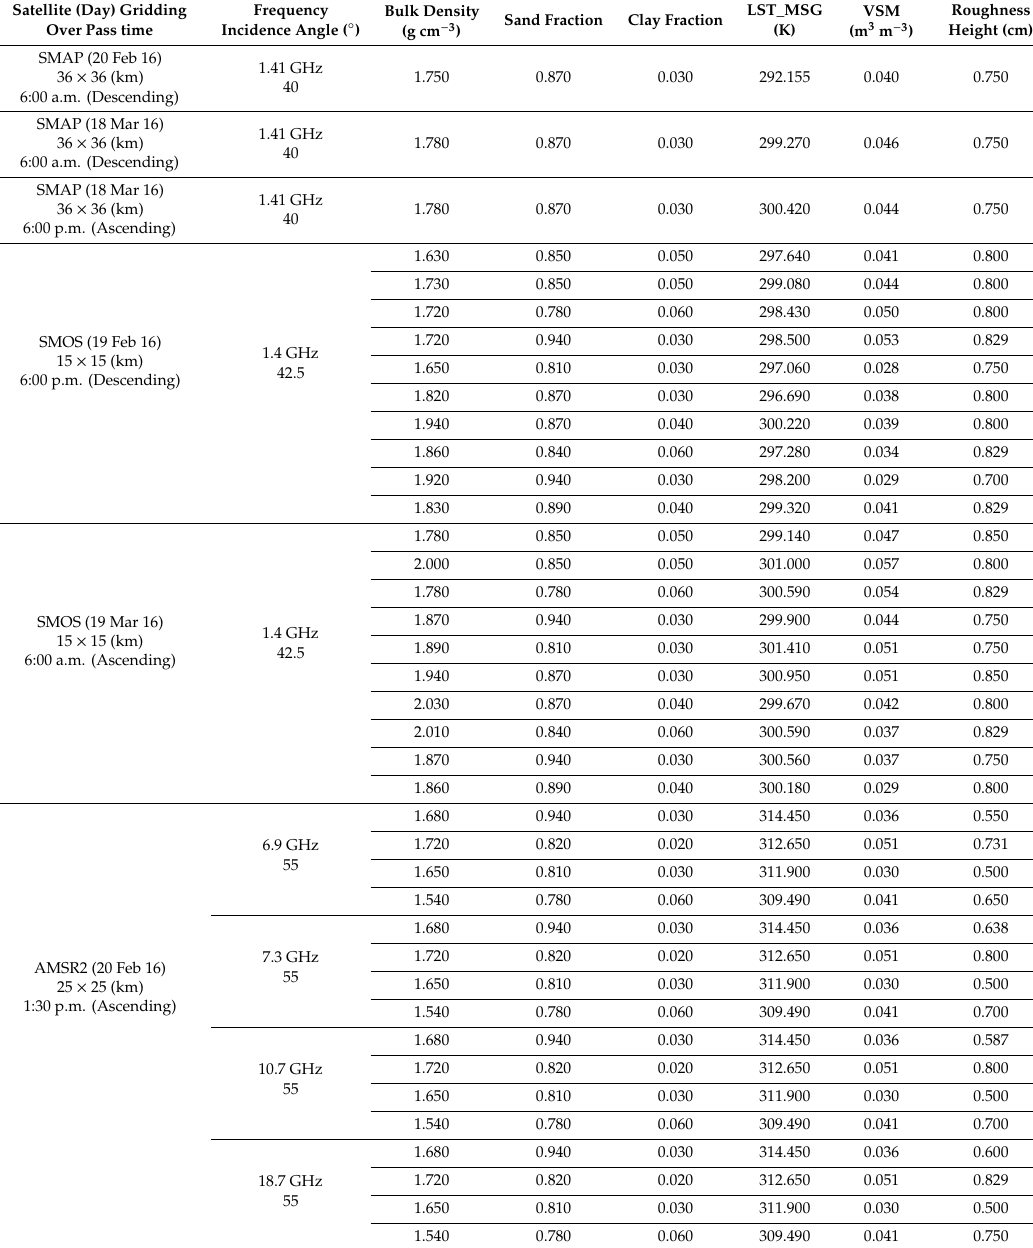
Table 2. Input parameters for the model